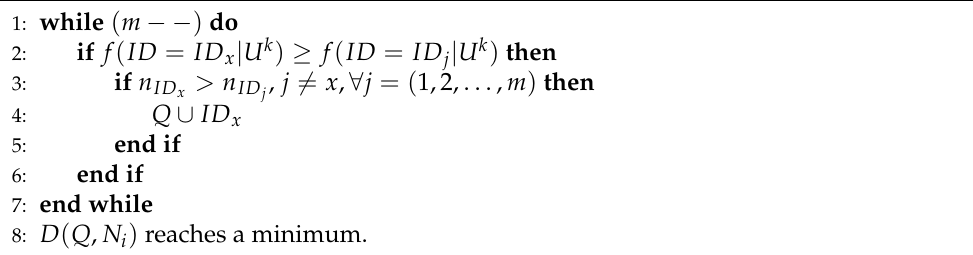
Algorithm 4 Poof of updating method for k-Modes of UAV